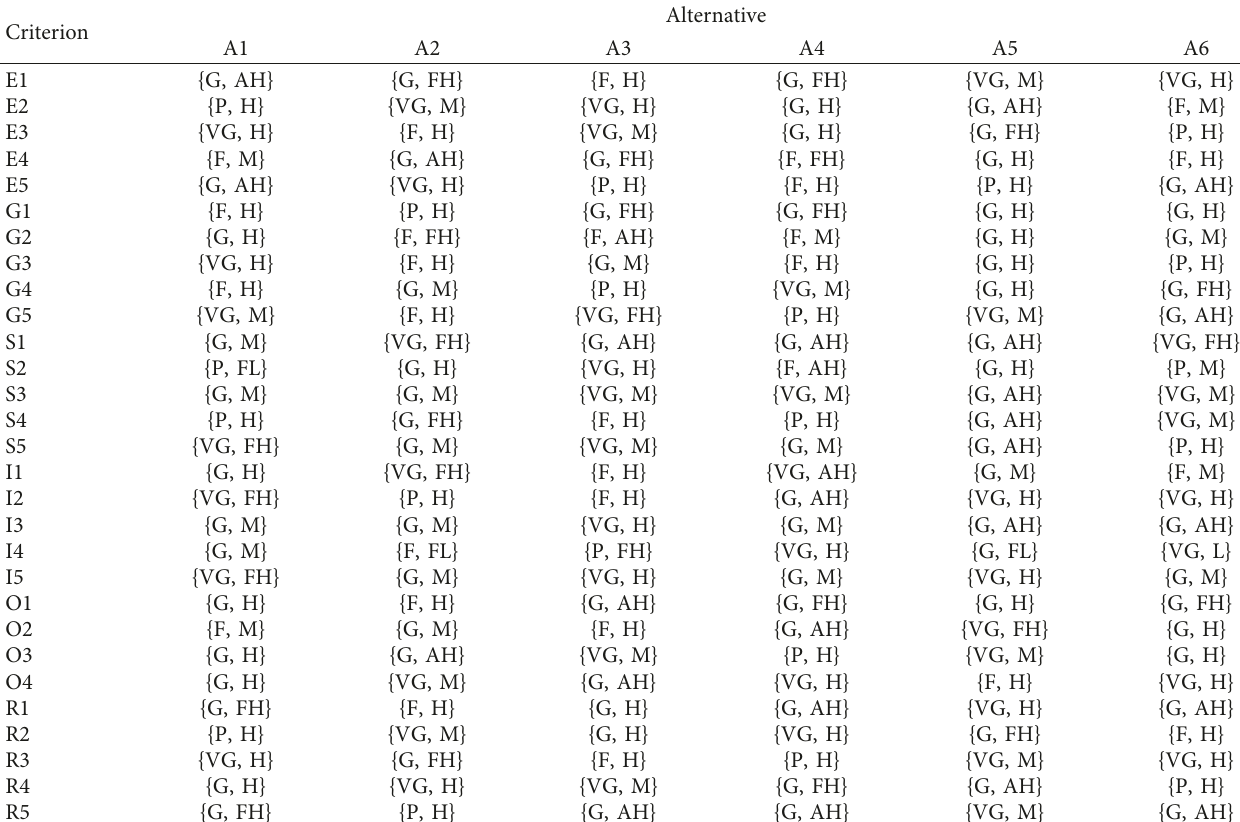
Table 9: Performance data of the six alternative partners (linguistic variables).